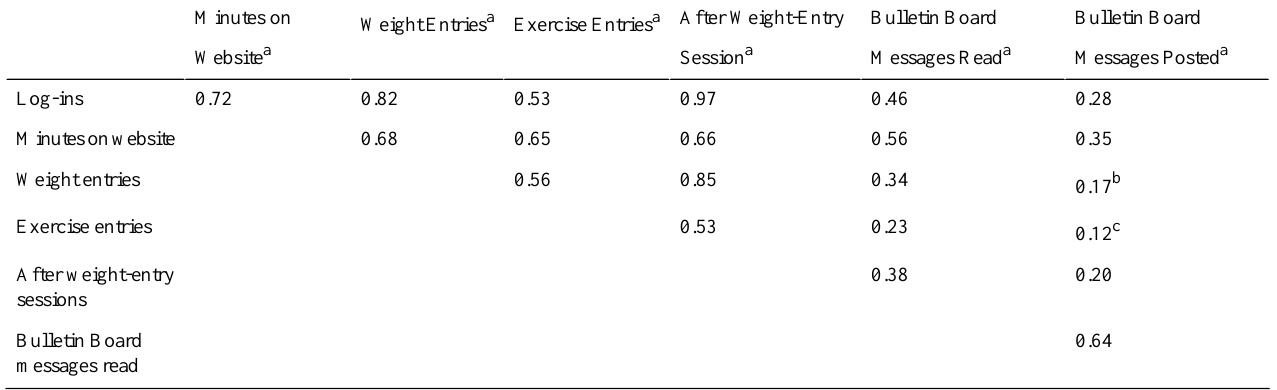
Table 3. Spearman correlations of website use